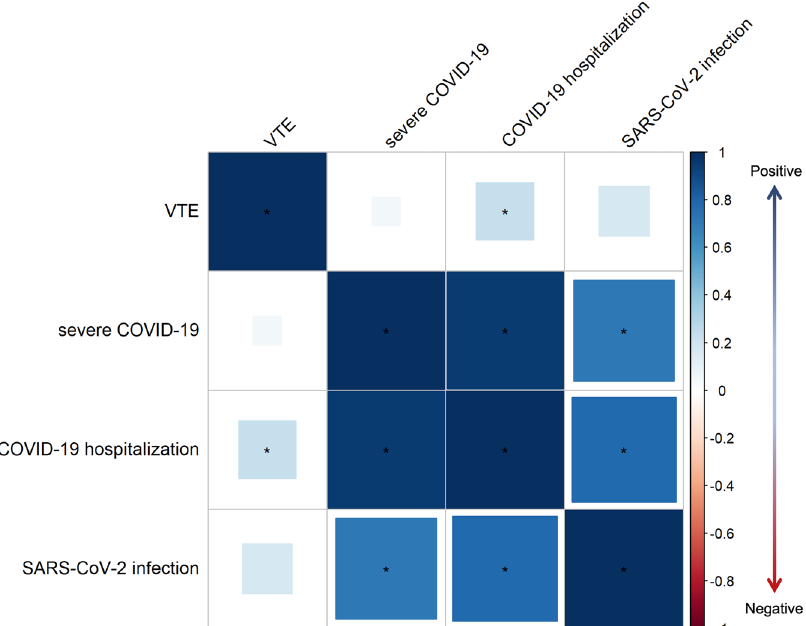
Fig. 1 Genetic correlation of VTE with COVID-19-related traits. Results were derived from linkage disequilibrium score regression (LDSC) analysis. Vertical axis represents the genetic correlation estimate Rg, with red indicating a negative correlation and blue indicating a positive correlation. The size of the colored squares is proportional to the P value, where larger squares represent a smaller P value. Asterisk represents signi fi cance ( P < 0.05). The presented data are available in Supplementary Table 2.